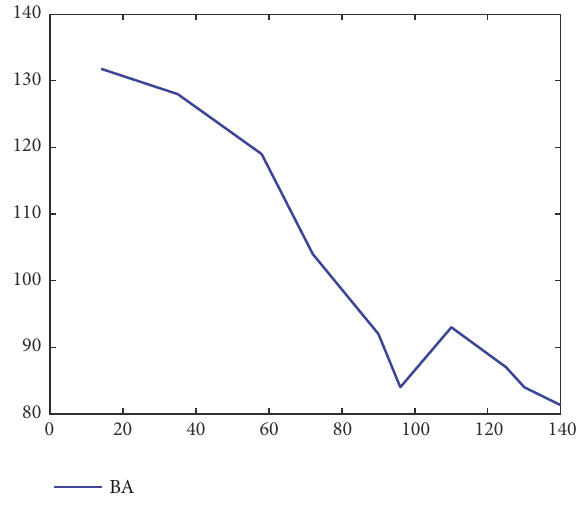
Figure 14: Convergence of